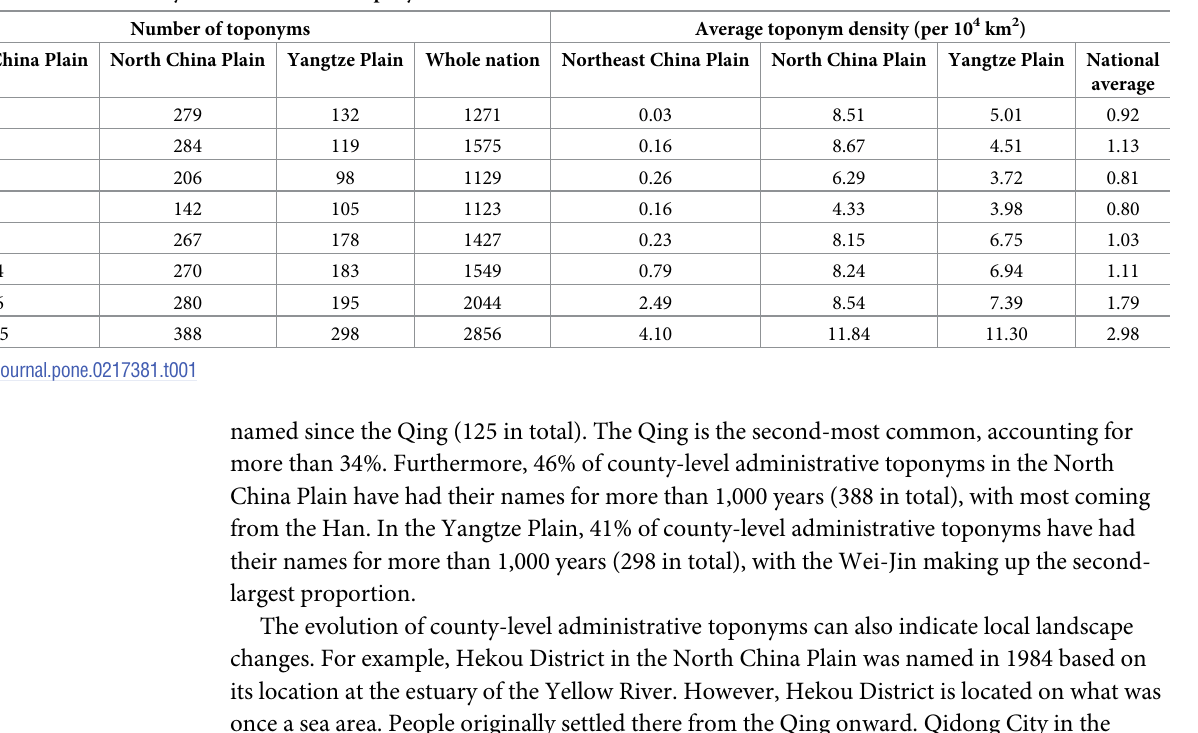
Table 1. Statistical characteristics of county-level administrative toponyms.